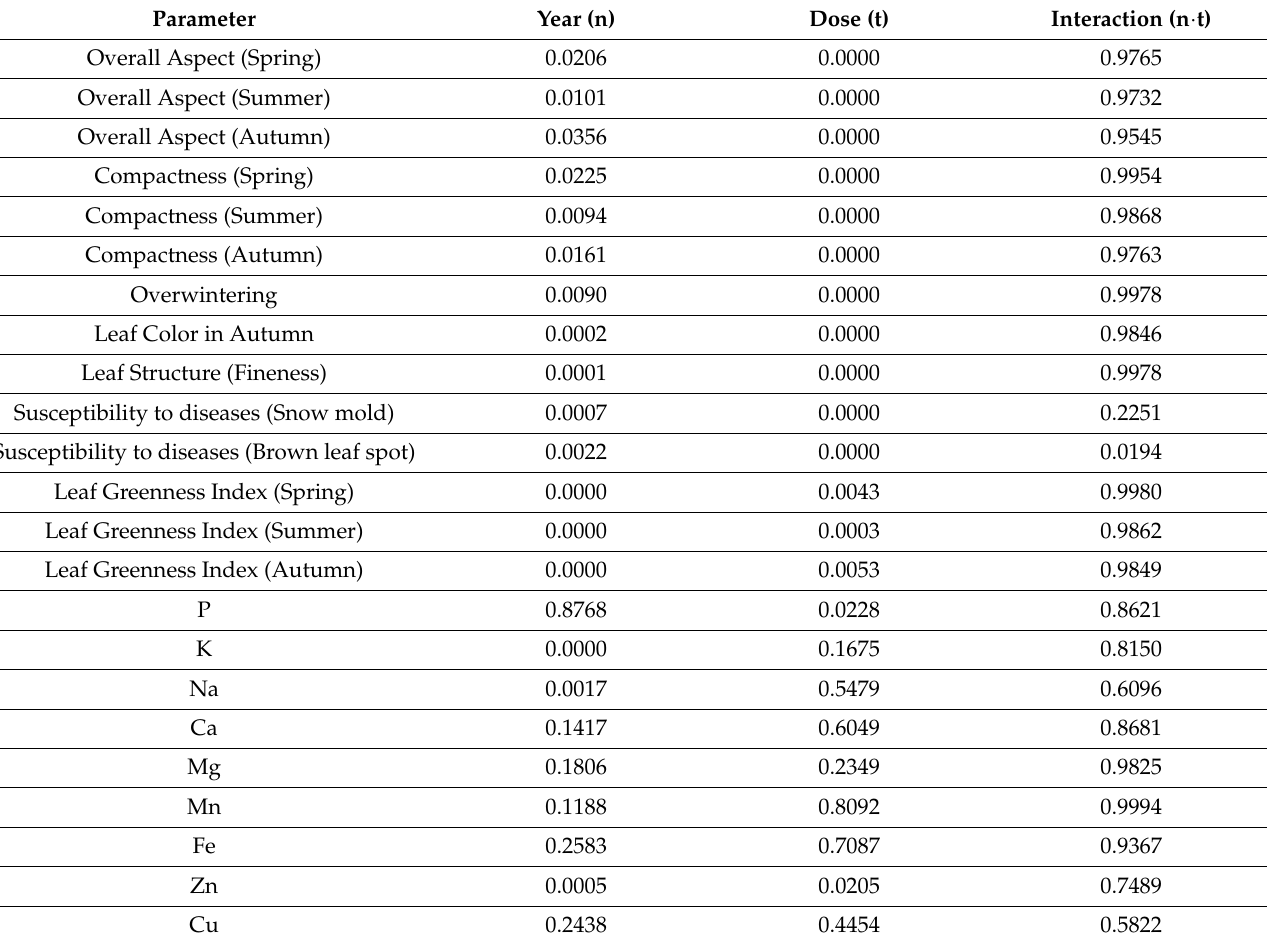
Table 1. Profitability value ( p -value) for the parameters evaluated (results of two-way ANOVA).